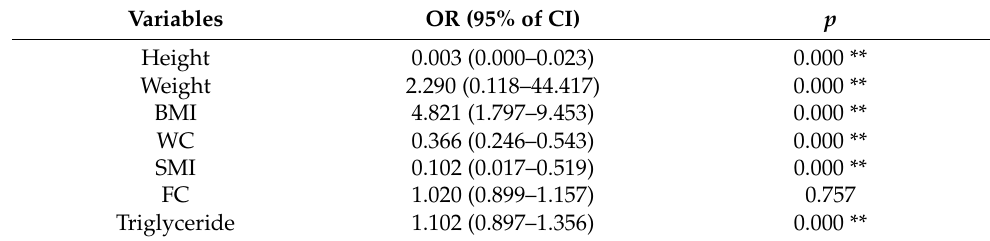
Table 5. Odds ratio for sarcopenia in males.